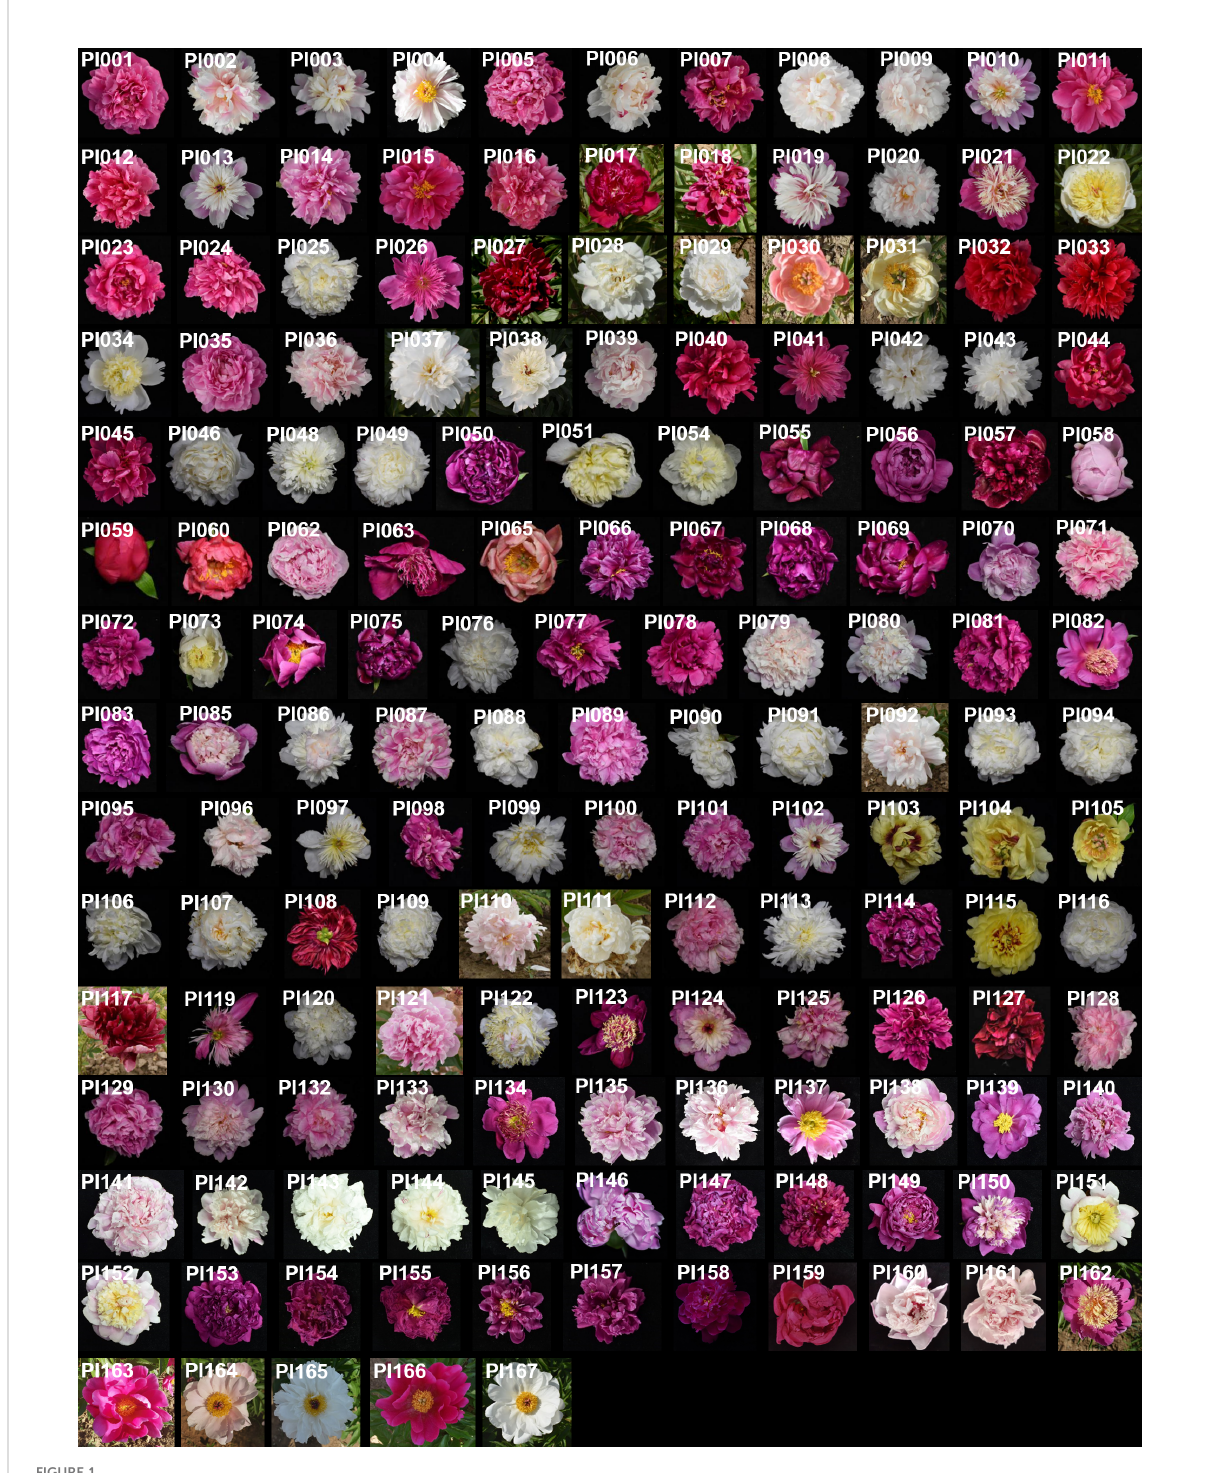
FIGURE 1 Flowers of 159 P. lacti fl ora accessions in bloom